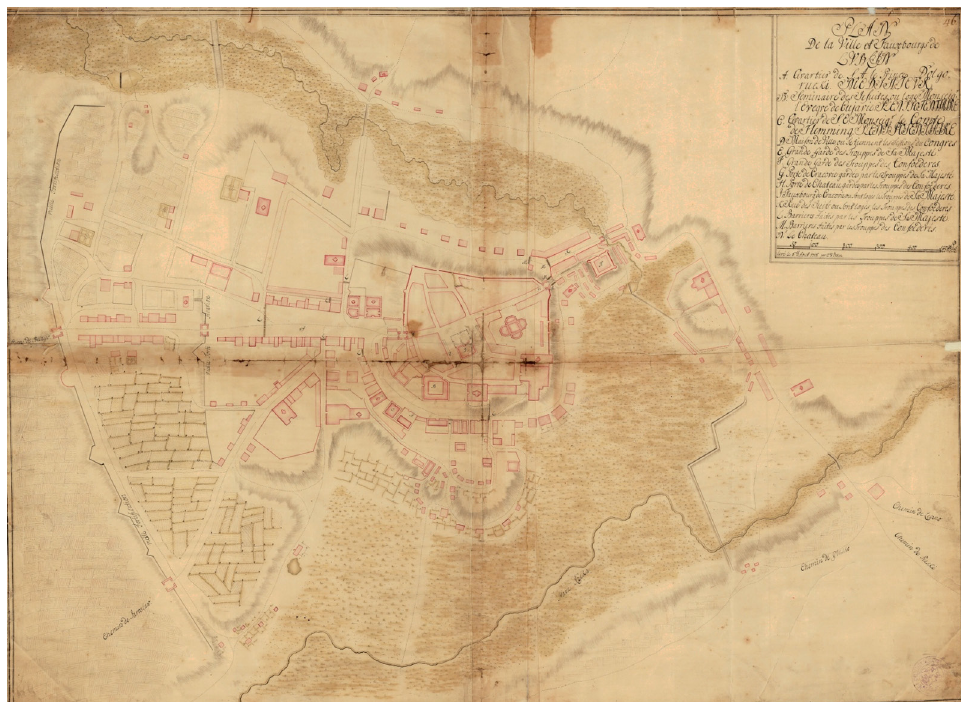
Fig. 1. City map of Lublin of 1716 (reduced size). Taken from: Leksykon. TeatrNN / Brama Grodzka